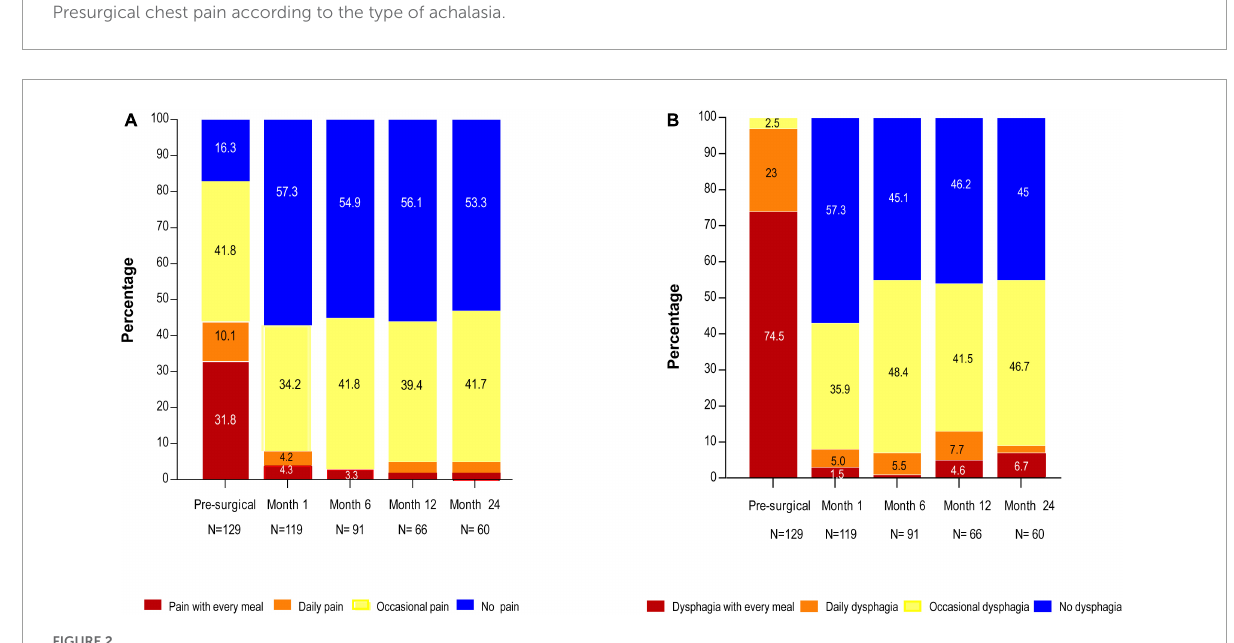
FIGURE2 (A) Chest pain and (B) dysphagia at presurgery, 1-, 6-, 12-, and 24-month post-surgery.